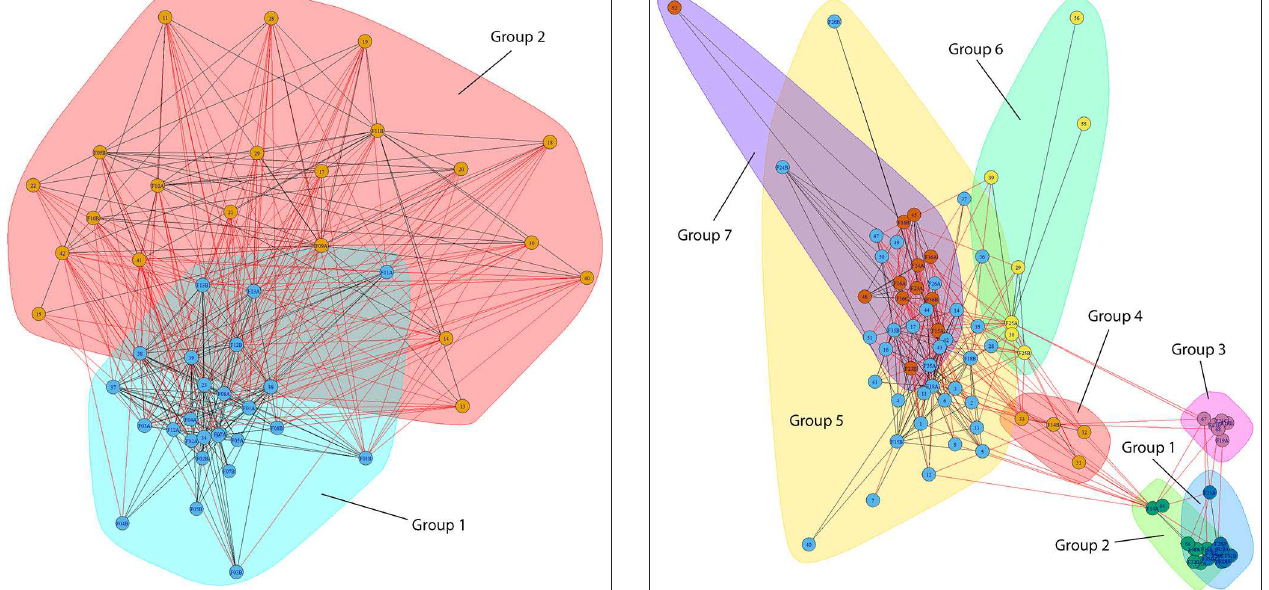
between the consecutive years was 21.1 days ( n = 17, SD = 30.8